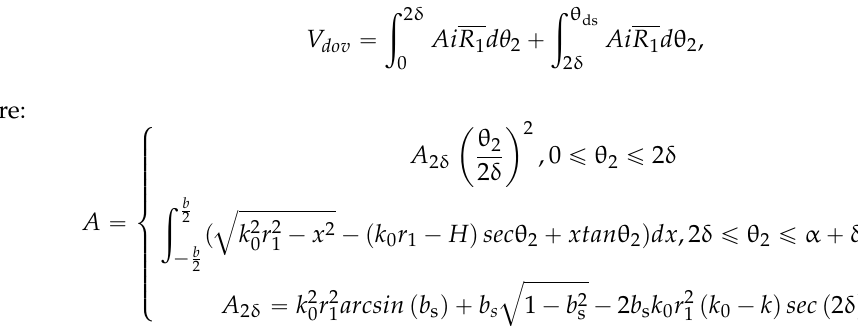
vs. ∆ y { d 1 of suction slide 1